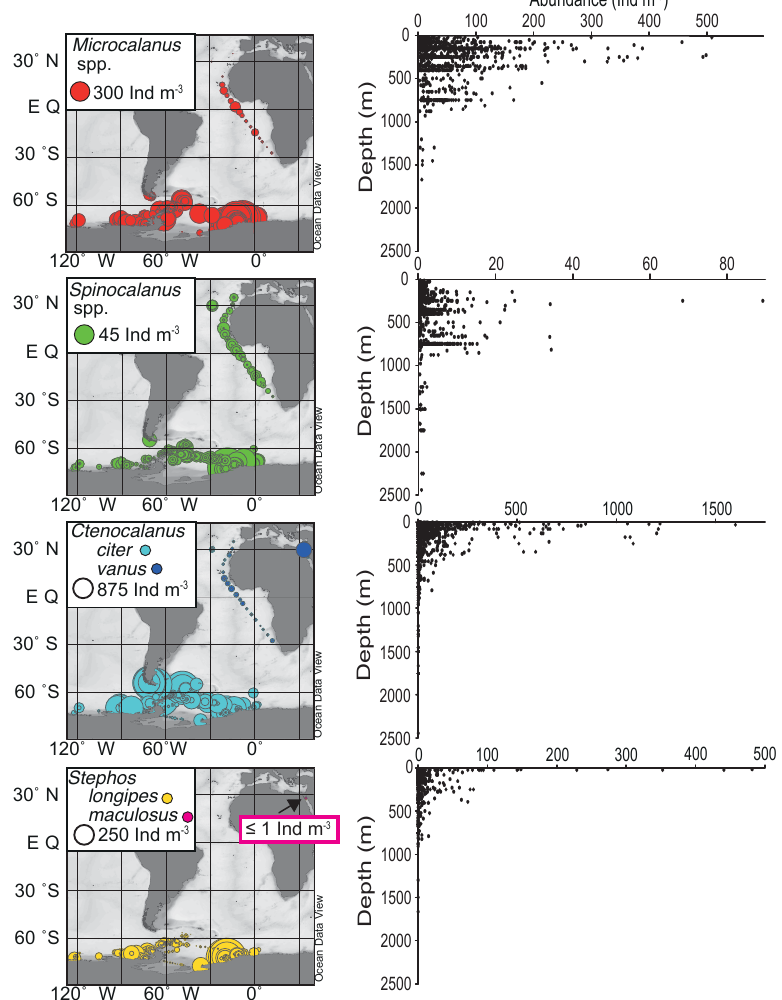
Figure 4. Distribution and abundance as individuals per cubic metre (Indm − 3 ) of selected genera ( Microcalanus , Spinocalanus , Cteno- calanus , Stephos ). Depth (m) is the mean depth of each sampling depth interval (“Depth water”).